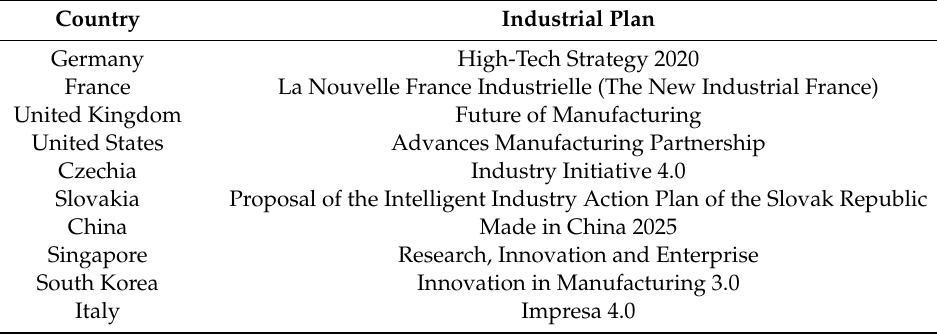
Table 1. Summary—National concepts, (Büchi et al. 2020),